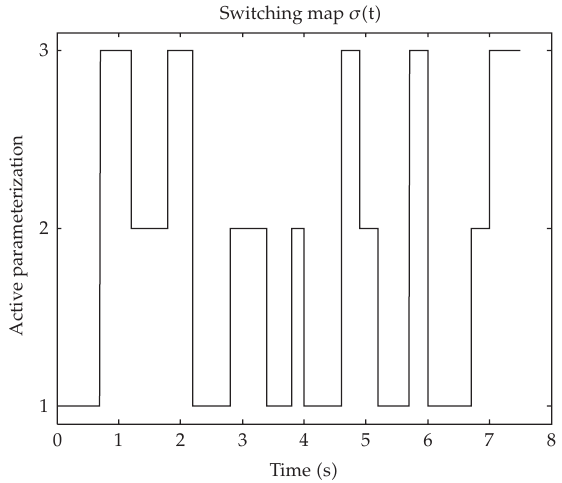
Figure 1: Switching map between di ff erent